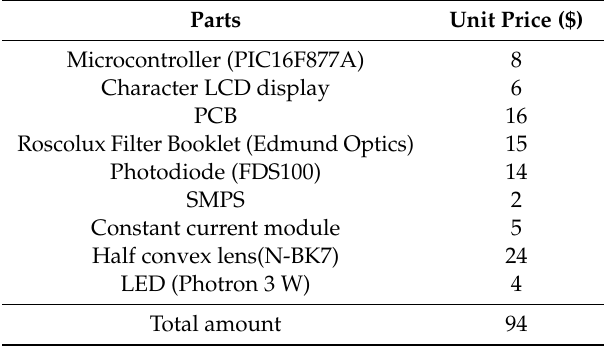
Table 1. List of components unit price to assemble the proposed fluorescence detection system.